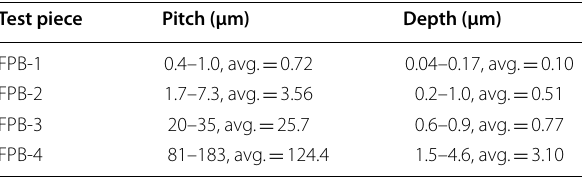
Table 3 Result of the antibacterial property test for S.